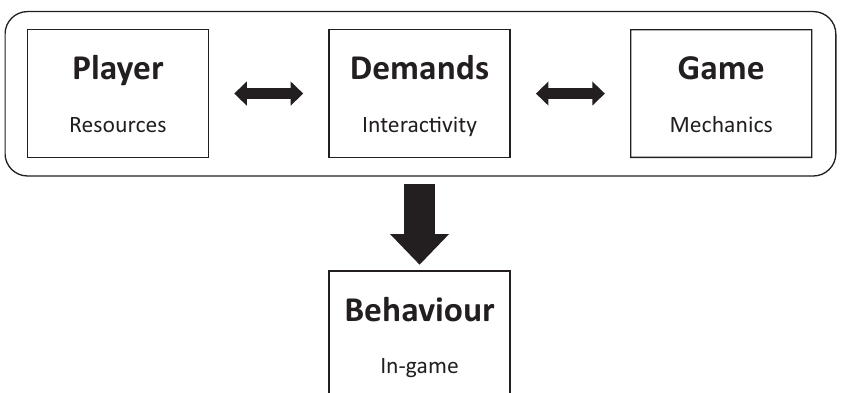
Figure 1. The author’s interpretation of the demand framework as it is conceptualized in Bowman (2018). Note: Demands function as an interaction between a player’s resources and the game’s mechanics, producing the player’s in-game behaviours.